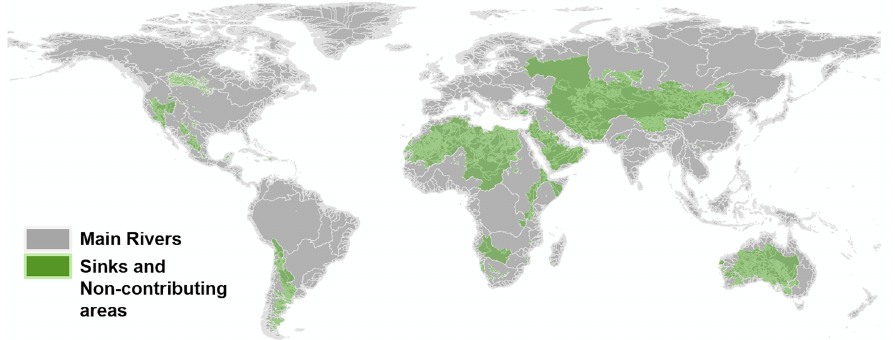
Figure 2. Major river basins and areas not contributing to river flow from land to the sea.